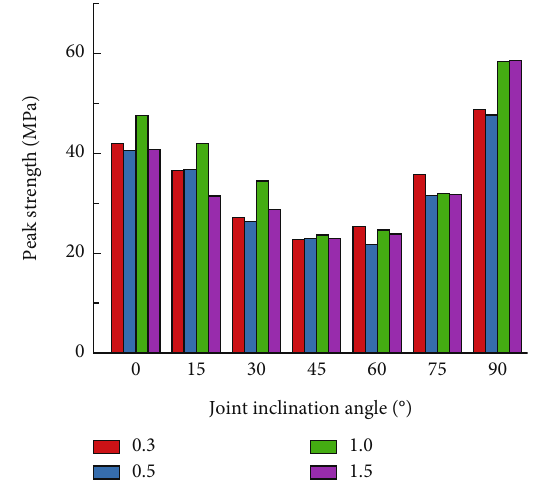
Figure 15: The peak strength variation for di ff erent sti ff ness ratio